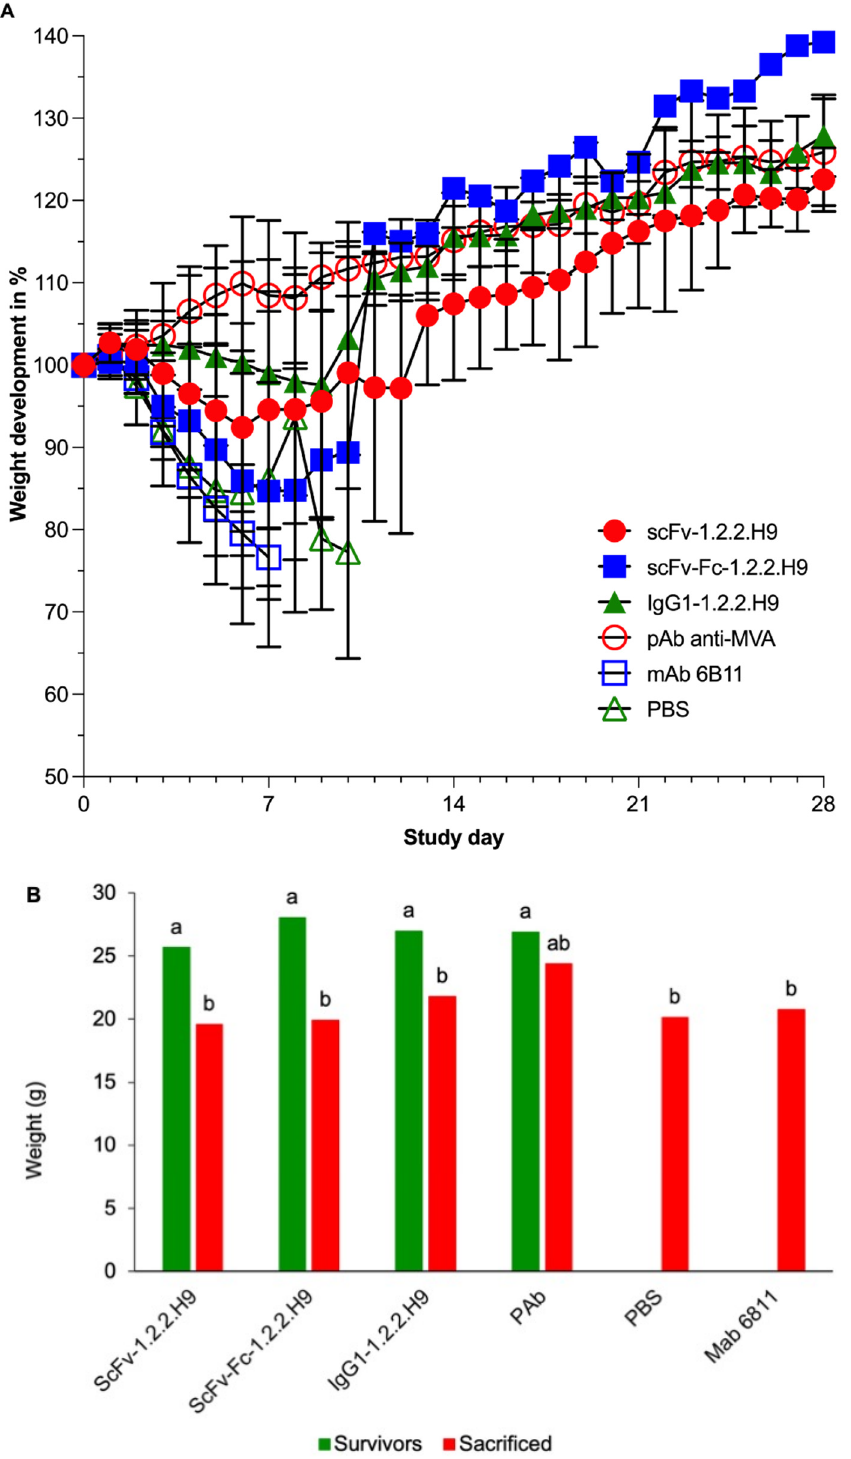
Figure 9. ( A ) Weight development and standard deviations per treatment group postvaccination on study day 0 and post-challenge on study day 1. The weight is plotted in proportion to the starting weight on study day 0. ( B ) Least square means for weight (in g) for the effect of survival ability of different treatment groups. Different letters illustrate the significant differences between the least square means of different factor levels ( p < 0.05).